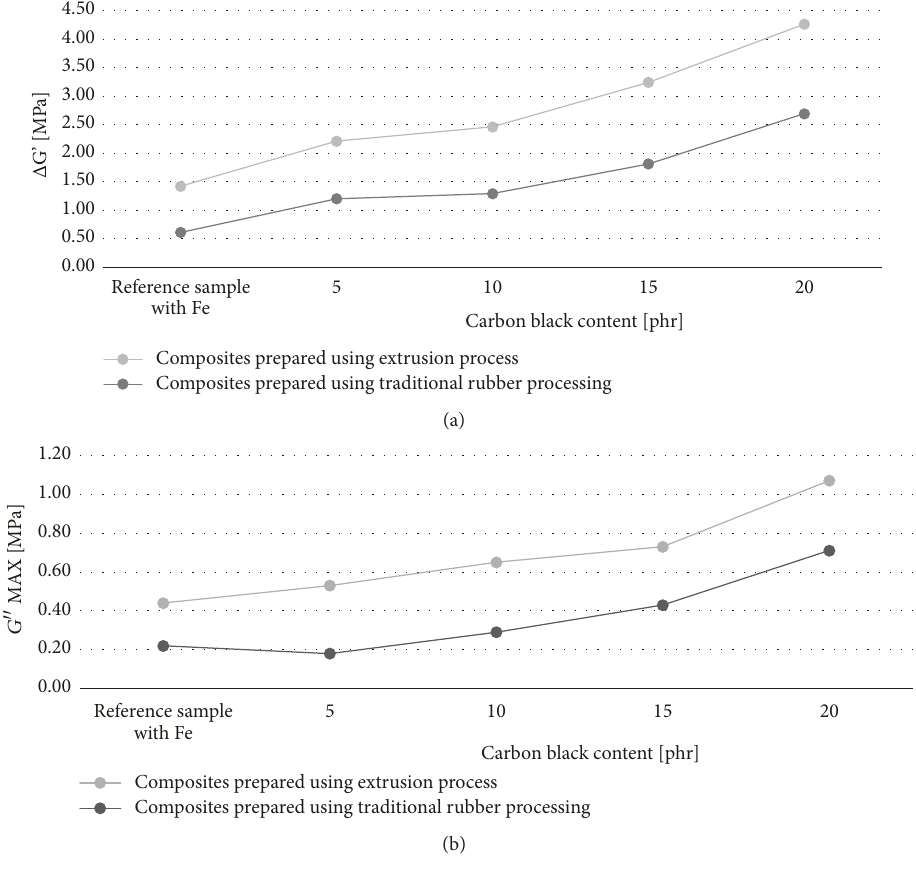
Figure 4: Influence of different processing methods on dynamic mechanical properties of magnetorheological composites: (a) Δ G 󸀠 : the increase the elastic modulus (Payne effect); (b) G 󸀠󸀠 MAX : the loss modulus determined under the max